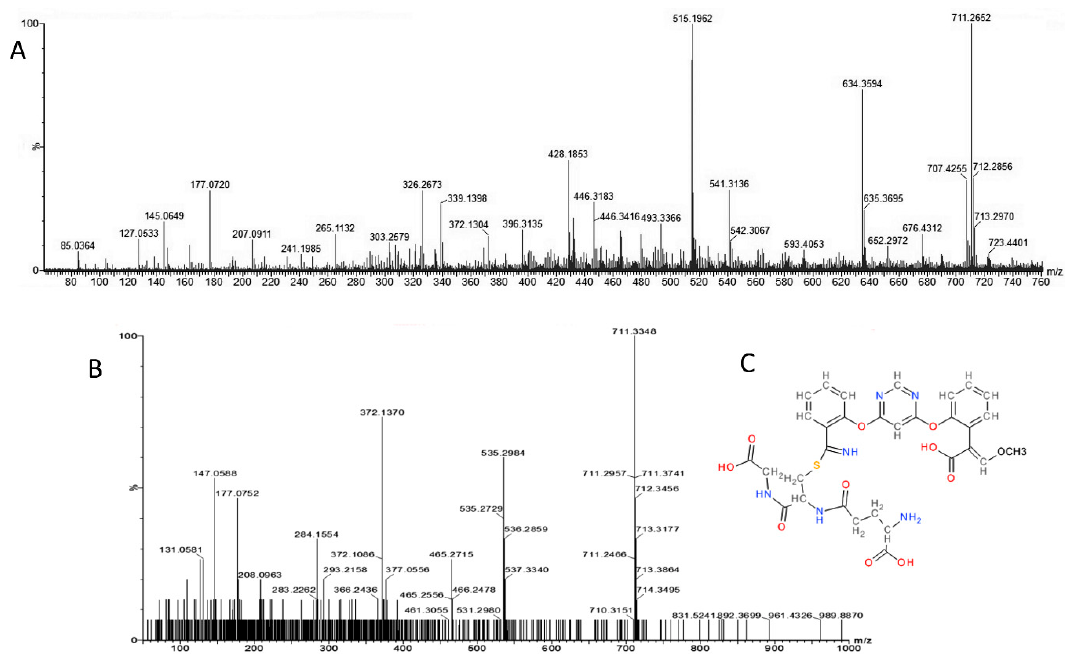
Figure 5. Analysis of the precursor specie 711 m / z . The identification of potential azoxystrobin conjugate at RT 18.36 min was possible by the analysis of MS survey profile (panel A ) of azoxystrobin treated roots and its DDA MS / MS profile (panel B ). The isolated MS / MS fragmentation profile reveals that the precursor of this azoxystrobin-conjugate / metabolite fits well with the azoxystrobin glutathione conjugate (panel C ) at the cyano group compatible with the compound 711.30 m / z as confirmed by the presence of 372 m / z in MS / MS of the isolated peak at 711.30 m / z (panel B). Further confirmation of this compound has been done by studying the neutral losses.